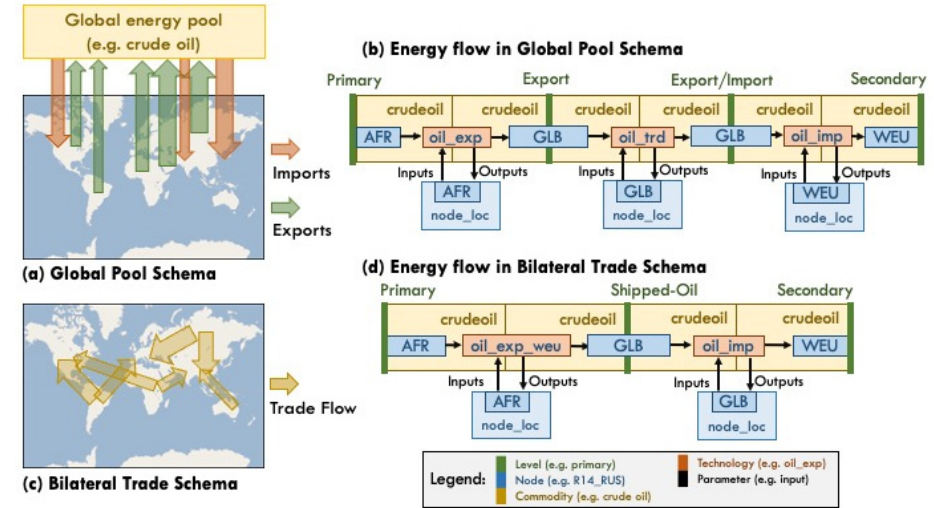
Figure 1. Schematics of the MESSAGEix global energy model. ( a ) Illustration of the “global pool schema” representation of international trade. There are 14 representative regions. Each region can export to (green) or import from (red) a global pool of each energy commodity (e.g., crude oil). ( b ) Energy flow in the global schema through inputs and output. Model “levels” are in green (e.g., primary, secondary, export, final), nodes are in blue (i.e., regions), commodities are in yellow (e.g., coal, crude oil), technologies are in orange (e.g., exports, imports), and parameters are in black (e.g., input, output). AFR represents Africa, GLB represents the global node, and WEU represents Western Europe. This flow therefore represents crude oil exports from Africa to Western Europe. ( c ) Illustration of the “bilateral trade schema” for international trade. We explicitly model bilateral trade flows for each energy commodity, thus representing trade as a network rather than a pooled resource. ( d ) Flow of energy in bilateral representation of trade. Note here that technologies now explicitly define the destination of, in this instance, crude oil exports. Commodities also explicitly denote the destination (“crudeoil_weu”).